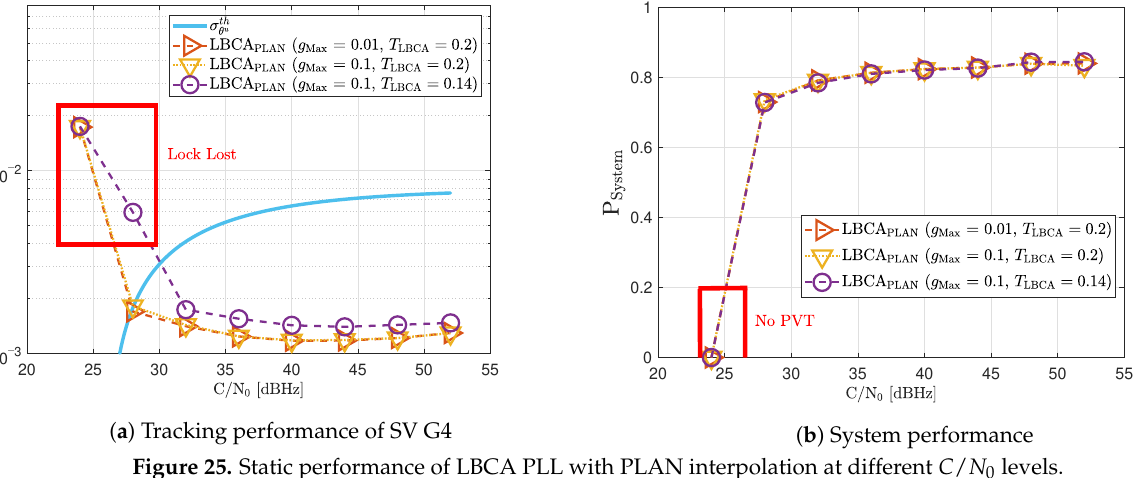
Figure 25. Static performance of LBCA PLL with PLAN interpolation at different C / N 0 levels.